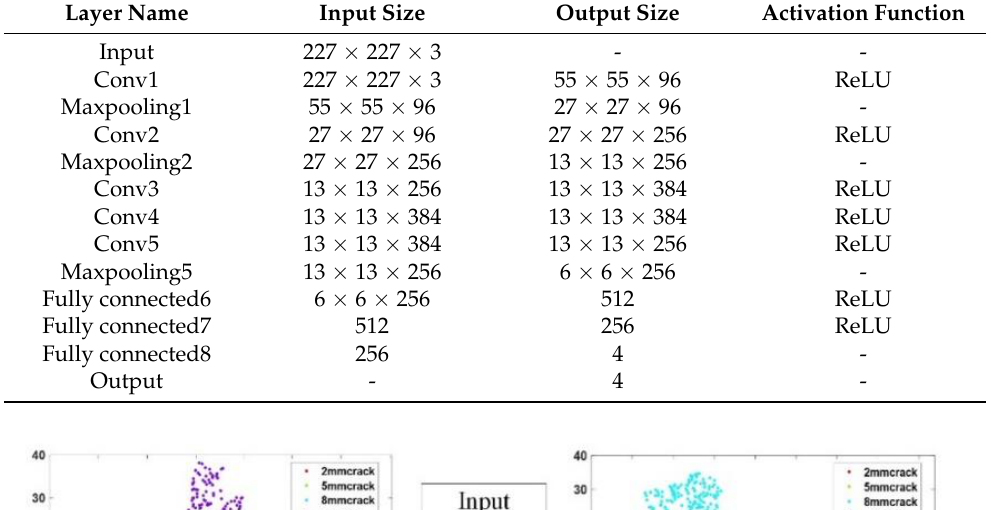
Table 6. Model parameters of AlexNet-TL.